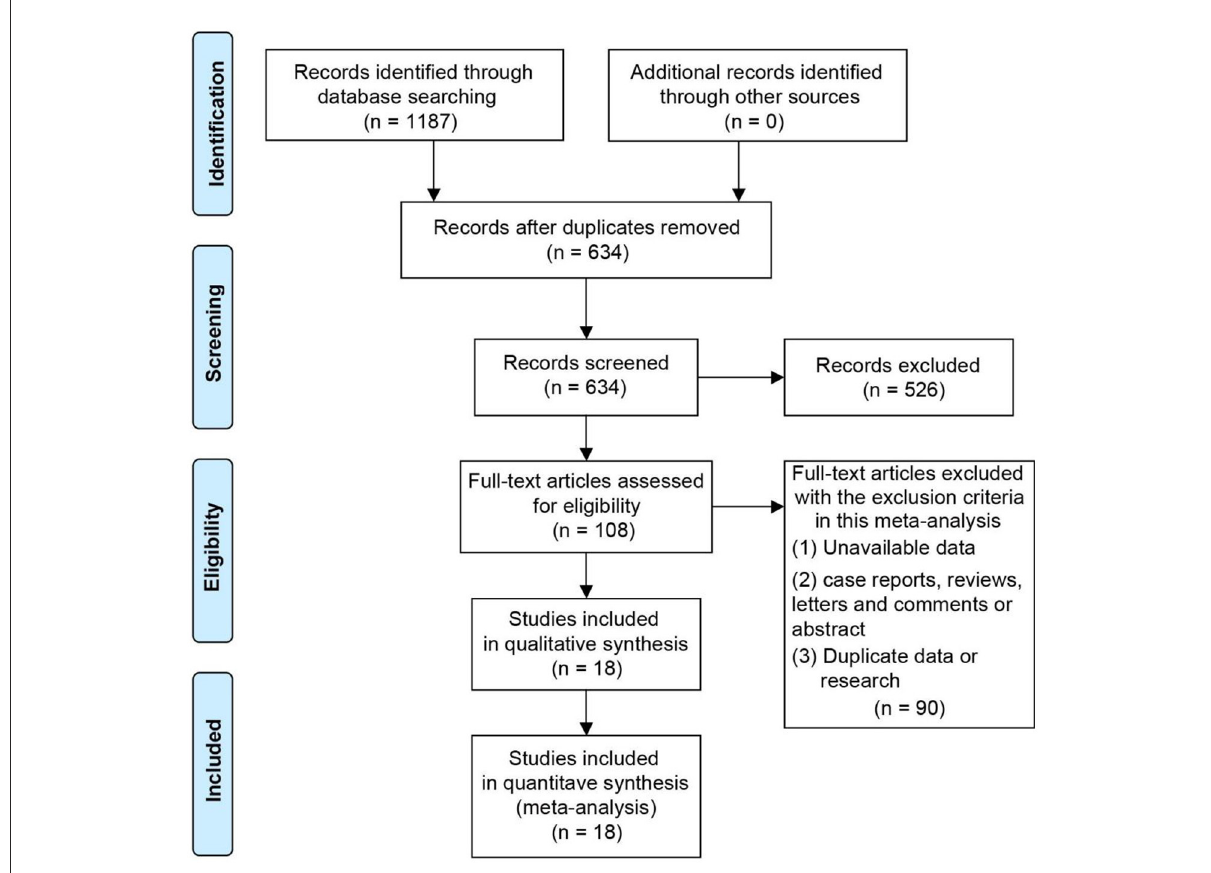
FIGURE1 Flow chart of the search and screening of the included literature.